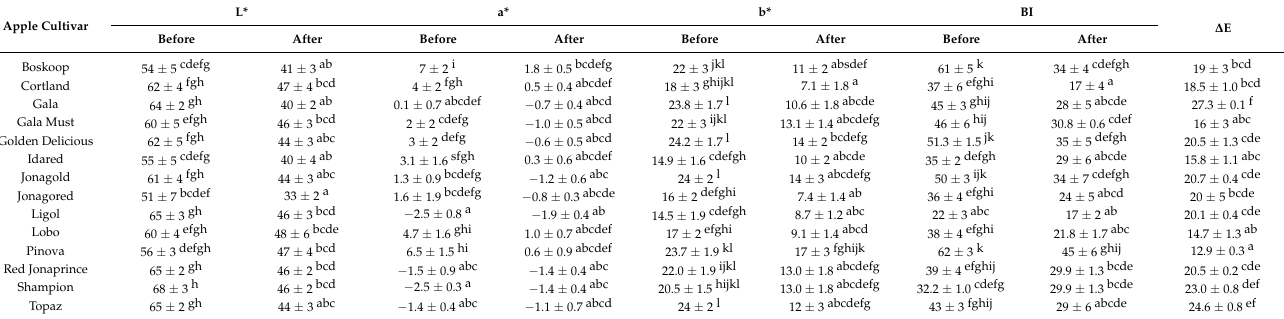
Table 2. Color parameters of apple cubes before and after